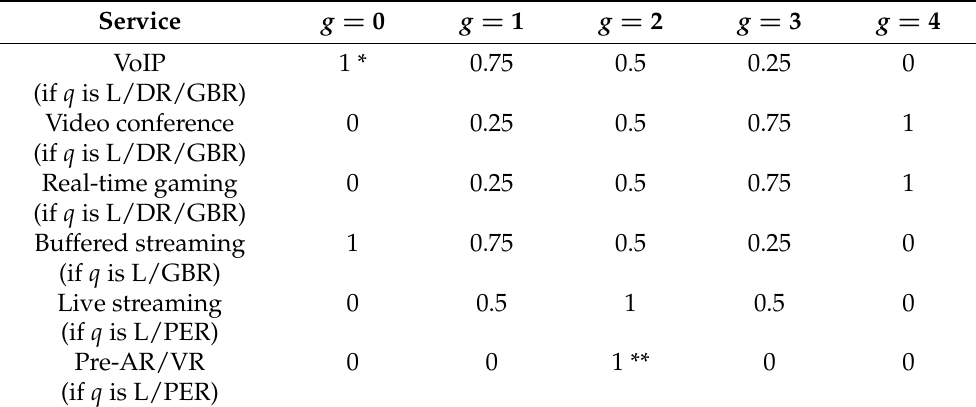
Table 6. Effect of numerology indexes for services in Table 4.